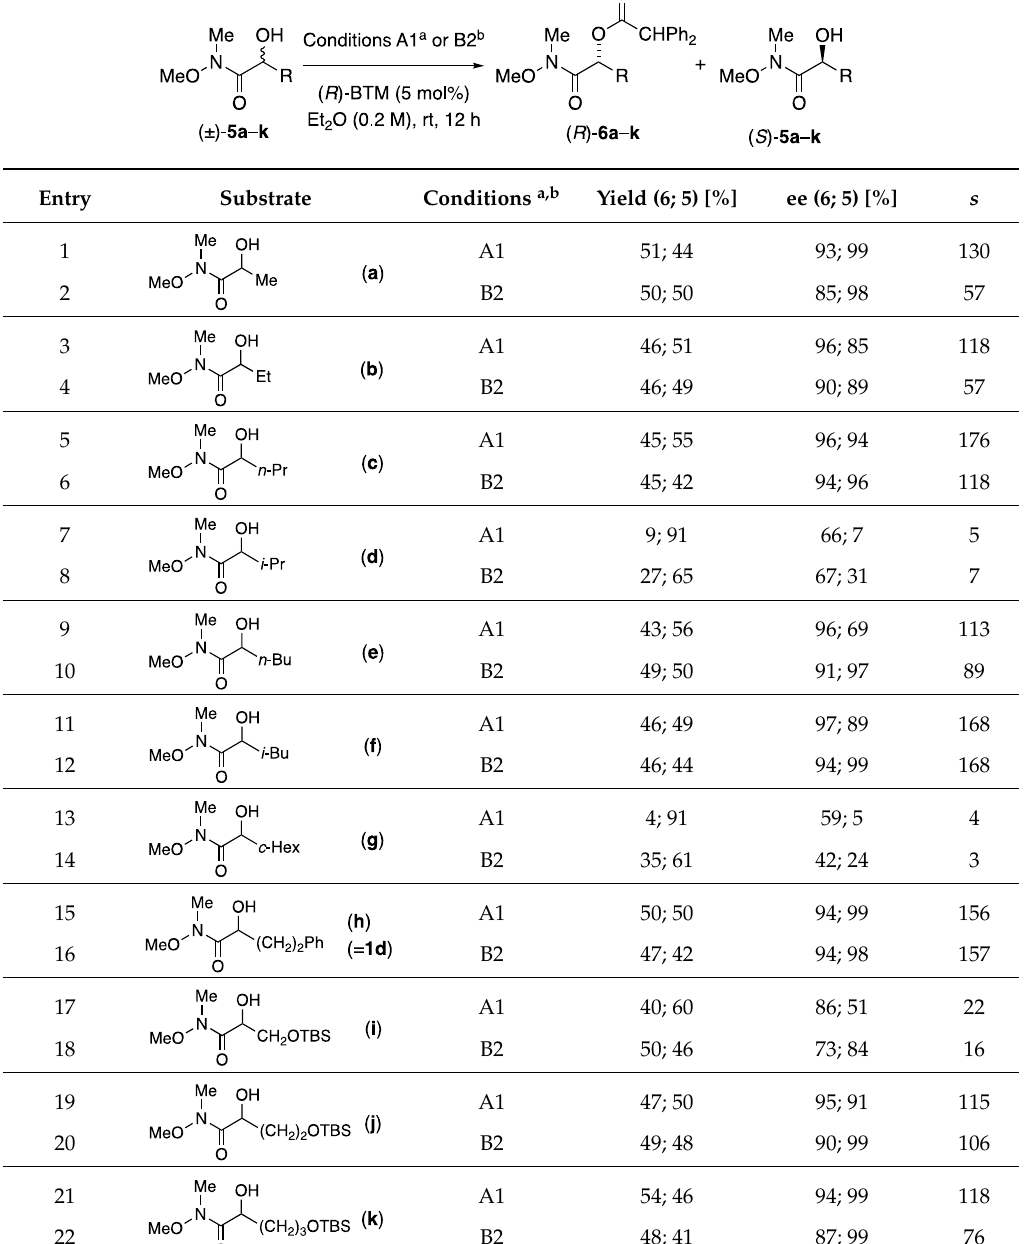
Table 3. KR of 2-hydroxy-Weinreb amide ((±)- 5a – 5k ).